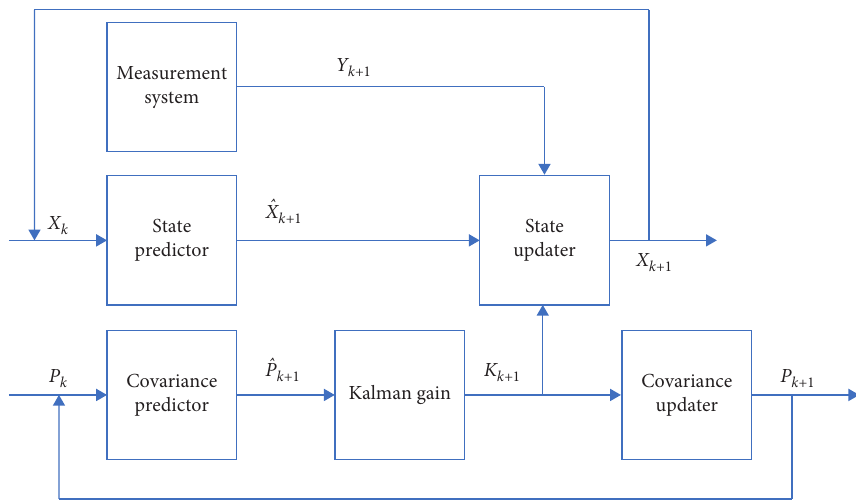
Figure 3: The flow chart of the EKF